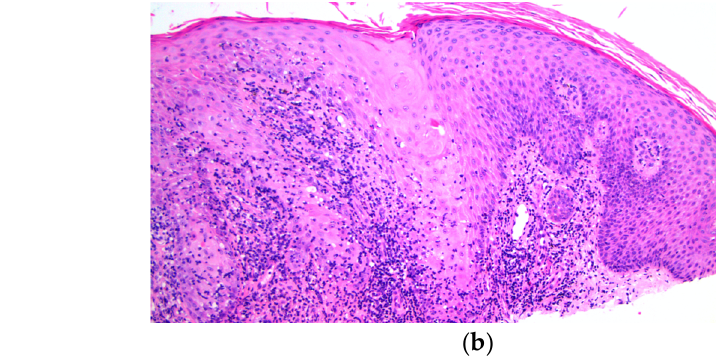
Figure 5. Histopathological photograph at 40× magnification ( a ) and 100× magnification ( b ) showing the features of the pseudoepitheliomatous hyperplasia (PEH) with haematoxylin eosin stain (H&E).